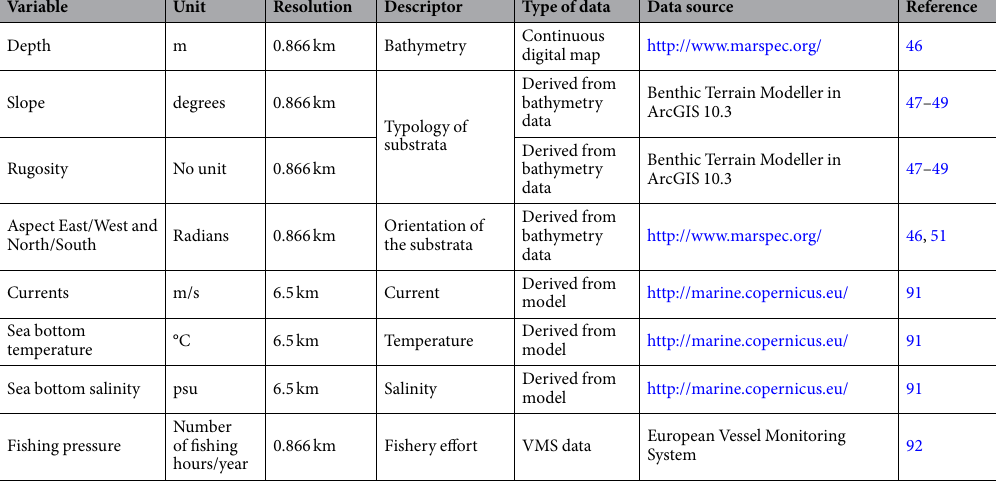
Table 2. Predictors used for habitat